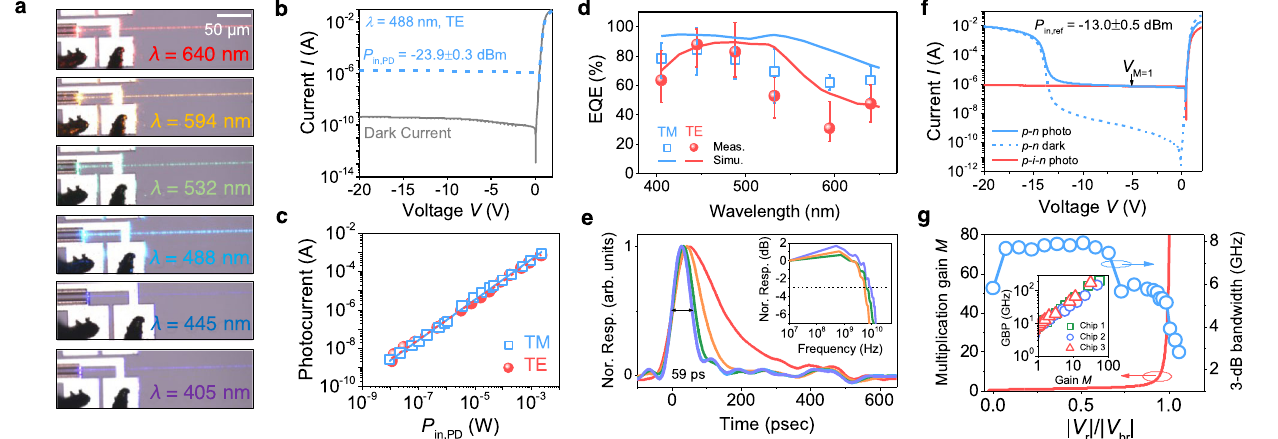
Fig. 2 | Characterization of the SiN-on-Si PDs (device length: 50 μ m). a Optical micrographs of the same device under test at different wavelengths. ( b - e ) Char- acterization of PIN devices ( l =50 μ m, measured W gn =200±20nm, t =120±10nm, and W gap =190±10 nm). b Current – voltage ( I − V ) characteristics without(darkcurrent)andwith P in , PD of − 23.9±0.3dBm. c I eph asafunctionof P in , PD from~10 − 9 to10 − 3 W. d MeasuredEQEat − 2Vagreeswellwiththesimulation.Three devicesfrom three chipsfarapart (>10cm)on the waferwere measured.Theerror bars show the maximum and minimum quantities measured for the three devices, andthedatapointsshowtheaverage. e Normalizedimpulseresponseofthedevice